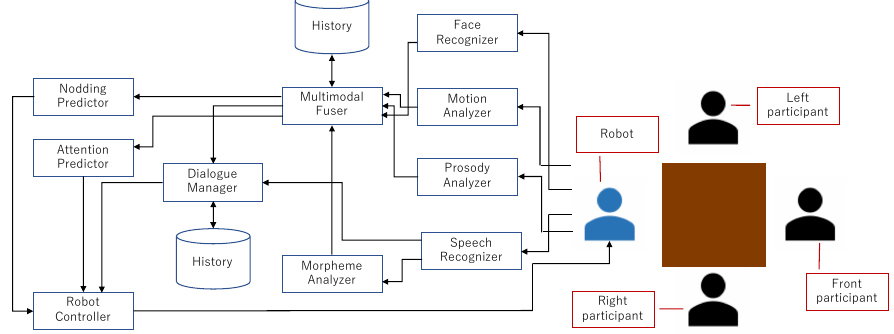
Figure 8. Proposed multimodal framework with the attention/nodding prediction modules